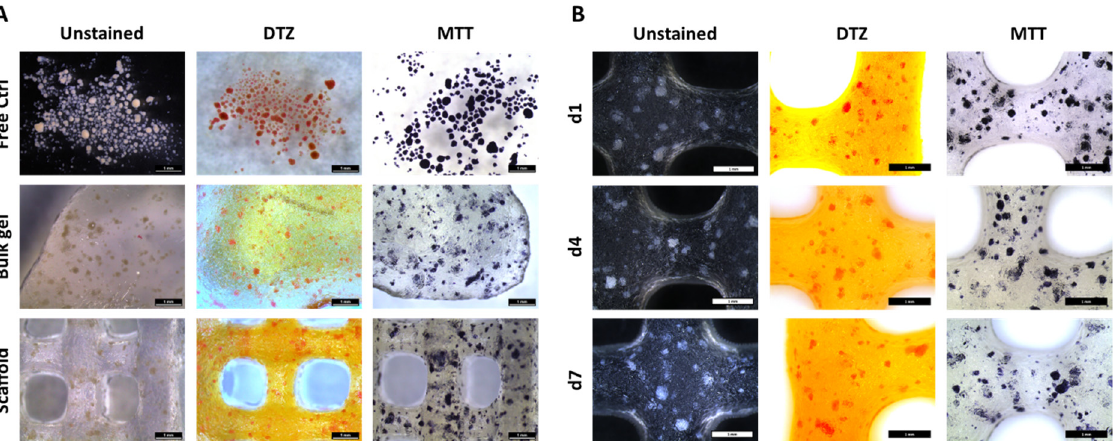
Figure 1. Distribution, insulin content (DTZ), and metabolic activity (MTT) of bioprinted NICC. ( A ) Influence of incorporation into algMC and bioprinting, d3 after incorporation. Free control NICC in suspension culture served as control for the influence of the material, unprinted NICC in algMC bulk gels as control for the extrusion process; ( B ) NICC in bioprinted scaffolds over 7 days of culture. Scale bars = 1 mm for all.